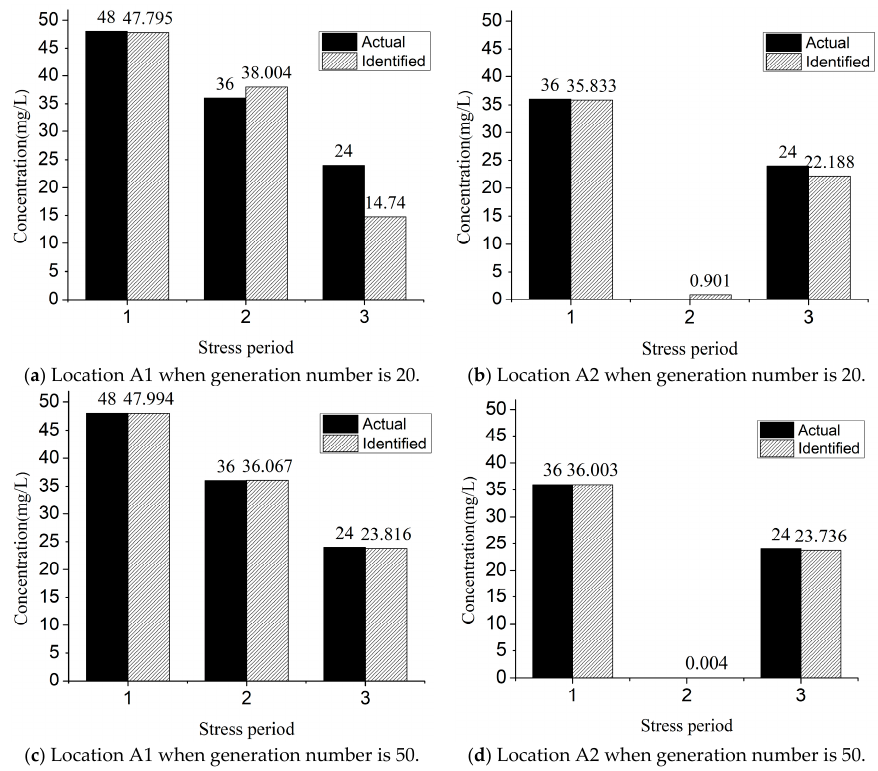
Figure 12. The identified results of A1 and A2 when generation number is 20 and 50.